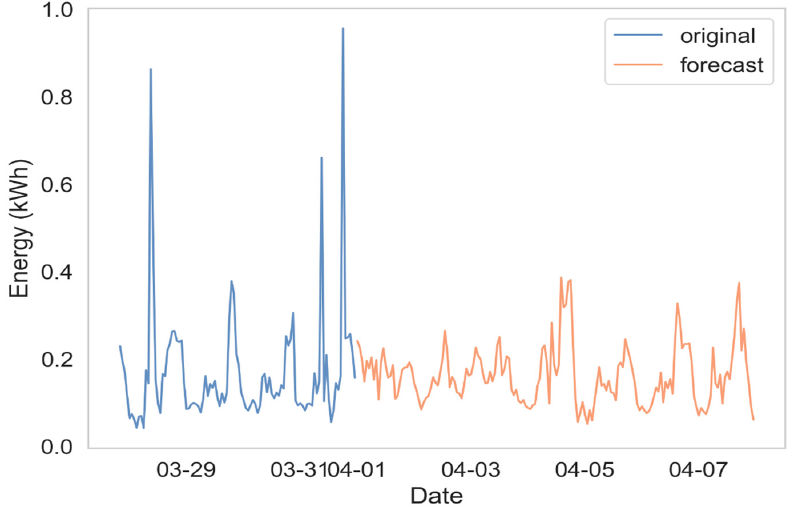
Figure 14. One week ahead load forecast by LSTM Predicted (red line) vs. actual load (blue line).